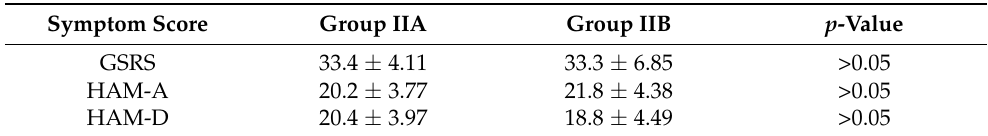
Table 3. Comparison of severity of symptoms between the two subgroups of IBS-D patients (Groups IIA and IIB); GSRS—Gastrointestinal Symptom Rating Scale; HAM-A—Hamilton Anxiety Rating Scale; HAM-D—Hamilton Depression Rating Scale; average ± SD.